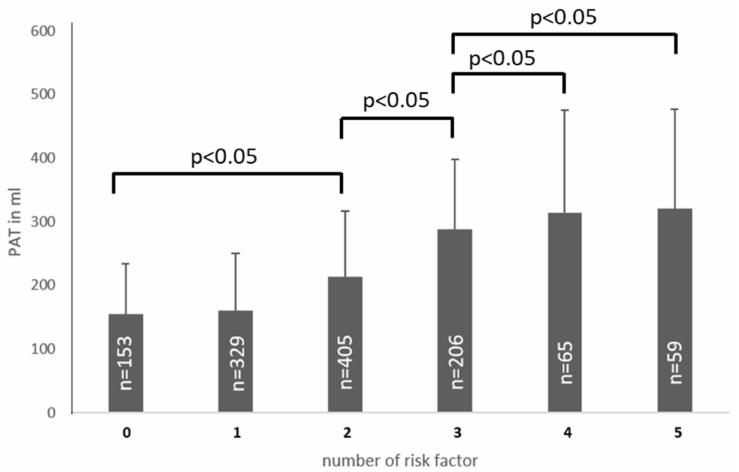
Figure 2. Number of risk factors increases PAT (in mL). A significant higher PAT volume could be measured in patients with 2 risk factors, in patients with 3 risk factors vs. 0–2 risk factors, in patients with 4 vs. 0–3 risk factors an in patients with 5 risk factors vs. 0–3 risk factors. The mean CAC score was 287 ± 188 (range 0–1208). The mean CAC score in smokers was 305 ± 191, compared to 269 ± 191 in non-smokers ( p < 0.01). PAT distribution in the different CAC groups is depicted in Figure 3. PAT volume increased with CAC score with a wide range of PAT volumes in each CAC score groups. In the low CAC score group (CAC score 0–10) 16.9% possessed a PAT volume within the 4th quartile, whereas 17% in the high CAC group (>400) showed a PAT volume within the 1st quartile.